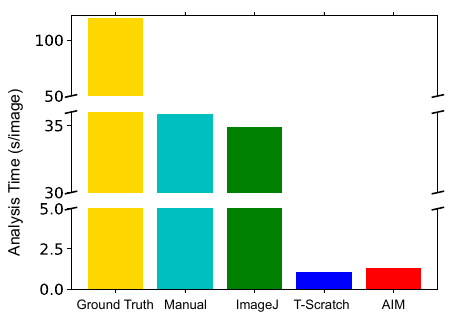
Figure 4. Average time required for the analysis of an image with the different tested